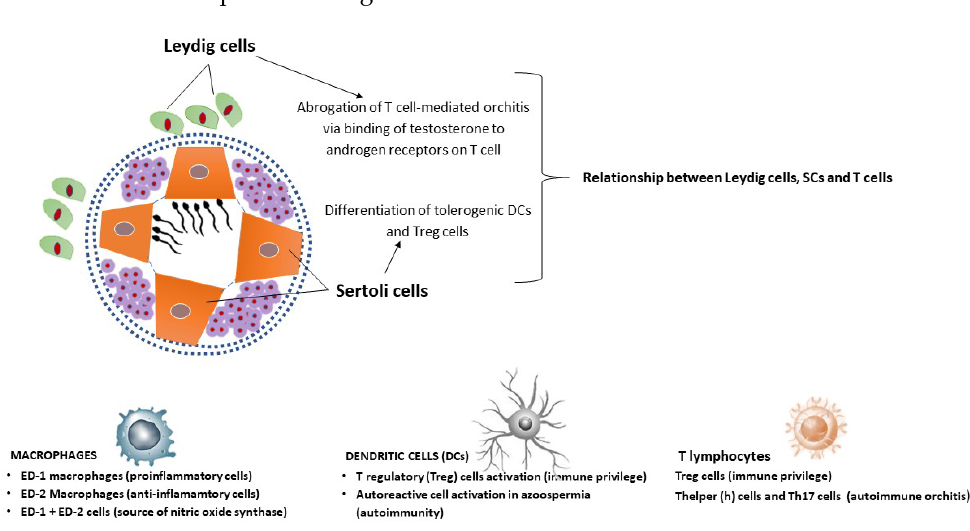
Figure 3. Macrophages, Dendritic cells and T cells sustain the testicular immune response. ED-2 macrophages, DCs and Treg cells keep immune privilege. Conversely, ED-1 macrophages and Th17 cells take part inchronic orchitis progression. Leydig cells attenuate autoimmune orchitis via release oftestosterone. SCs maintain the immune privilege via activation of tolerogenic DCs and Treg cells.